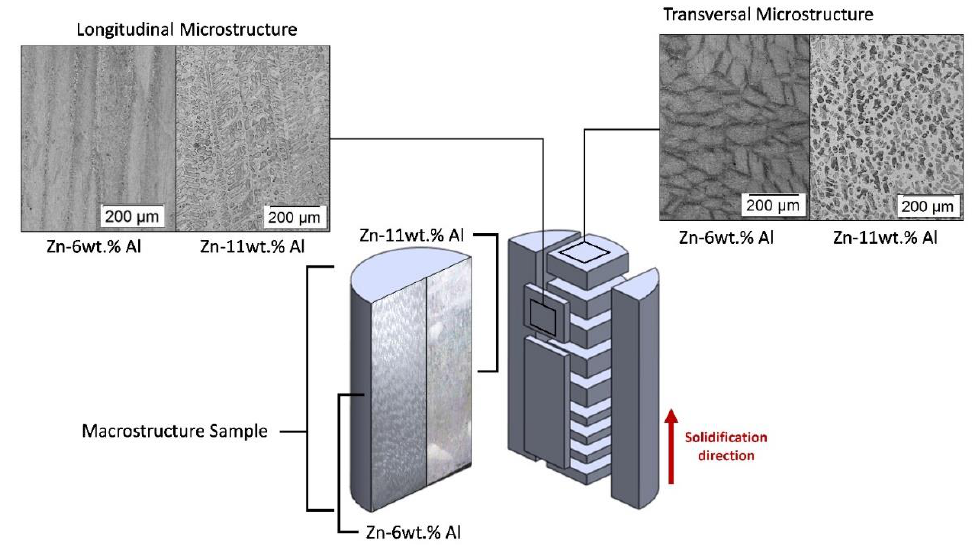
Figure 3. Schematic representation of samples extracted along the length of the castings for further microstructural characterization.